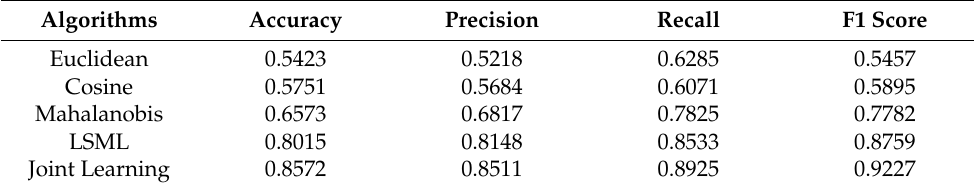
Figure 6. Performance of feature learning, similarity learning joint learning. Table 6. Performance comparison between existing